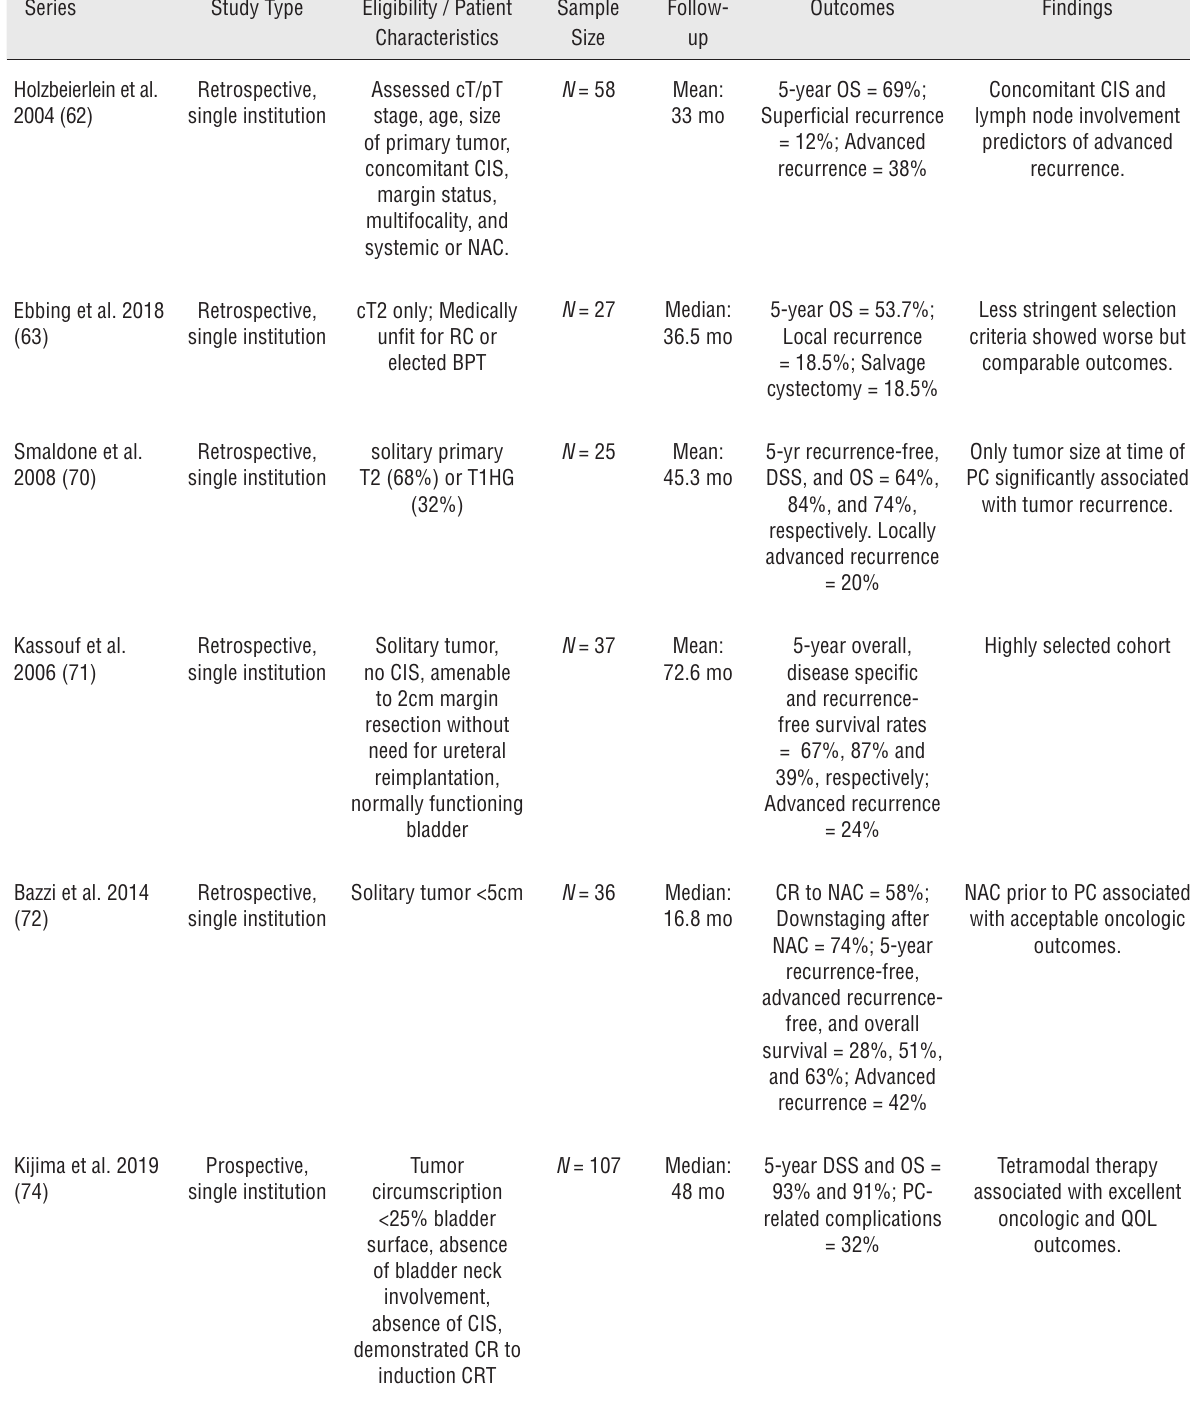
Table 3 - Partial cystectomy series identified in this